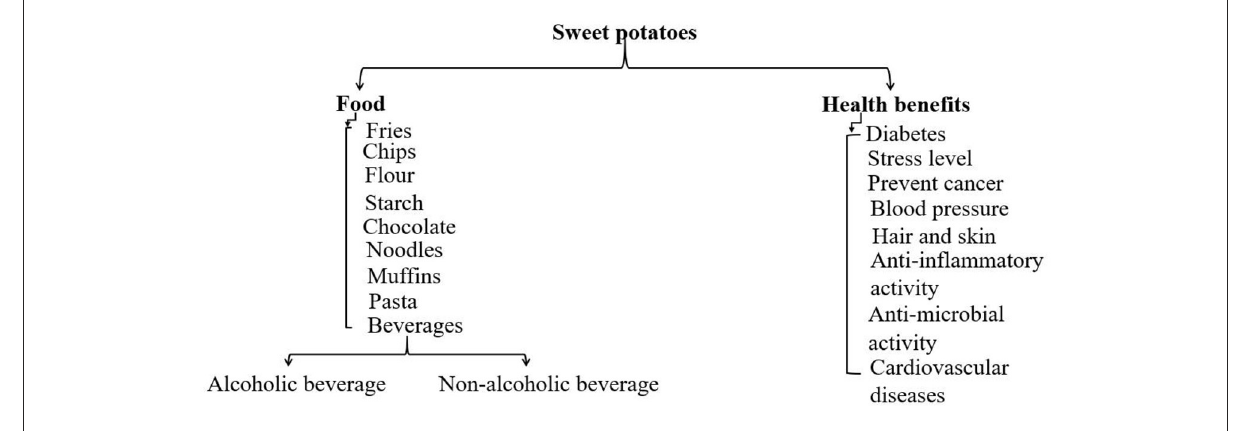
FIGURE1 Classification of and health benefits of dried sweet potato